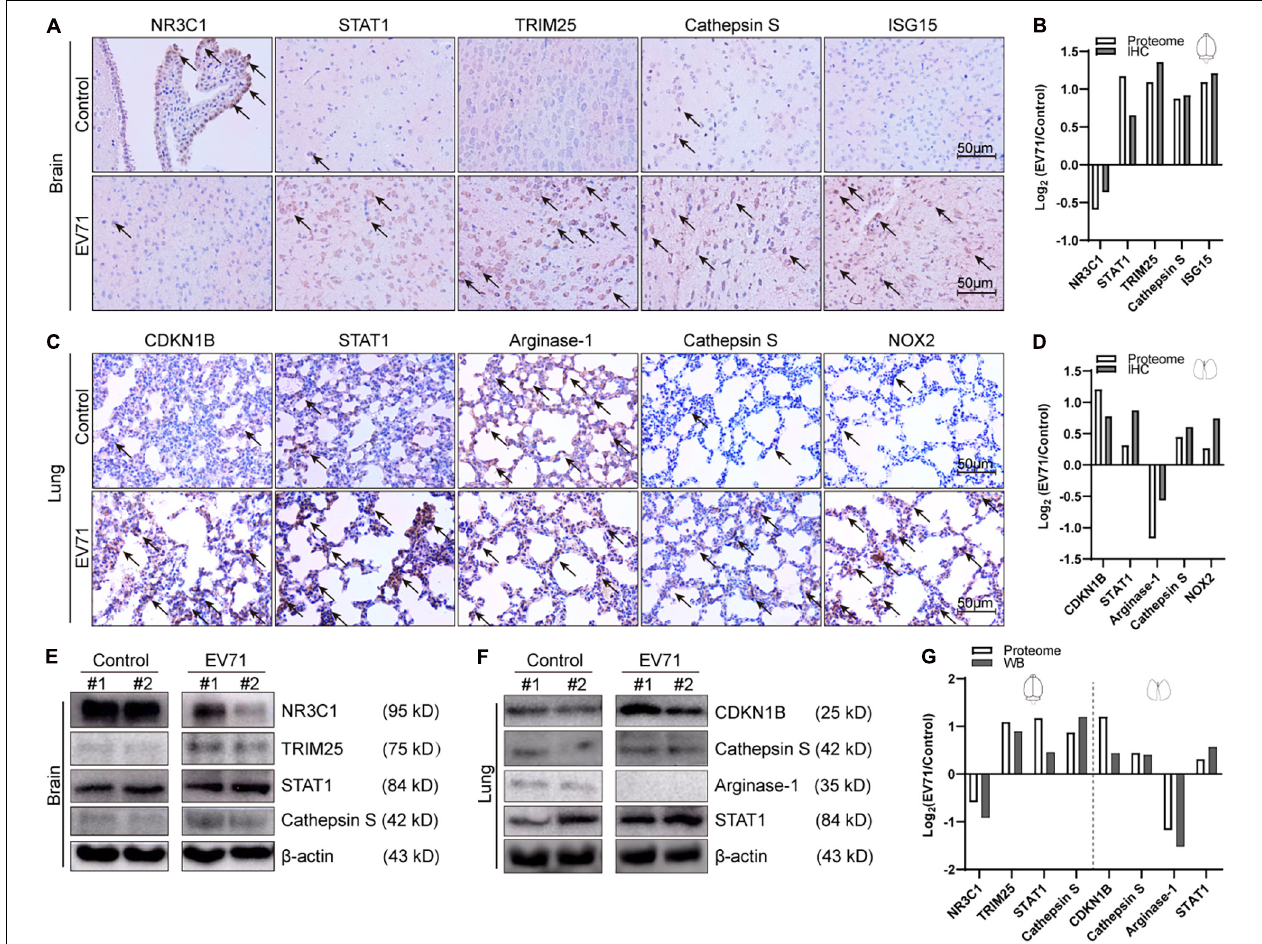
FIGURE 5 | Comparison of laboratory measurements and proteome. At 7 dpi, EV71-infected mice ( n = 4) and controls ( n = 4) were euthanized, and brain and lung tissues were taken out for immunohistochemical (IHC) staining ( n = 2) and Western blotting ( n = 2). (A) Immunohistochemical analyses of NR3C1, STAT1, TRIM25, Cathepsin S, and ISG15 in EV71-infected brain tissues and control brain tissues. Black arrows represent positively stained areas (brown). (B) Comparison of intensities of IHC staining and proteomic data (TMT reporter ion intensities) in the brain. (C) Immunohistochemical analyses of CDKN1B, STAT1, Arginase-1, Cathepsin S, and NOX2 in EV71-infected lung tissues and control lung tissues. (D) Comparison of intensities of IHC staining and proteomic data (TMT reporter ion intensities) in the lung. (E) Western blotting analyses of NR3C1, TRIM25, STAT1, and Cathepsin S in EV71-infected brain tissues and control brain tissues. (F) Western blotting analyses of CDKN1B, Cathepsin S, Arginase-1, and STAT1 in EV71-infected lung tissues and control lung tissues. (G) Comparison of intensities of immunoblots and proteomic data (TMT reporter ion intensities) in the brain and lung. All laboratory measurements were repeated at least three times. Data are displayed as log2